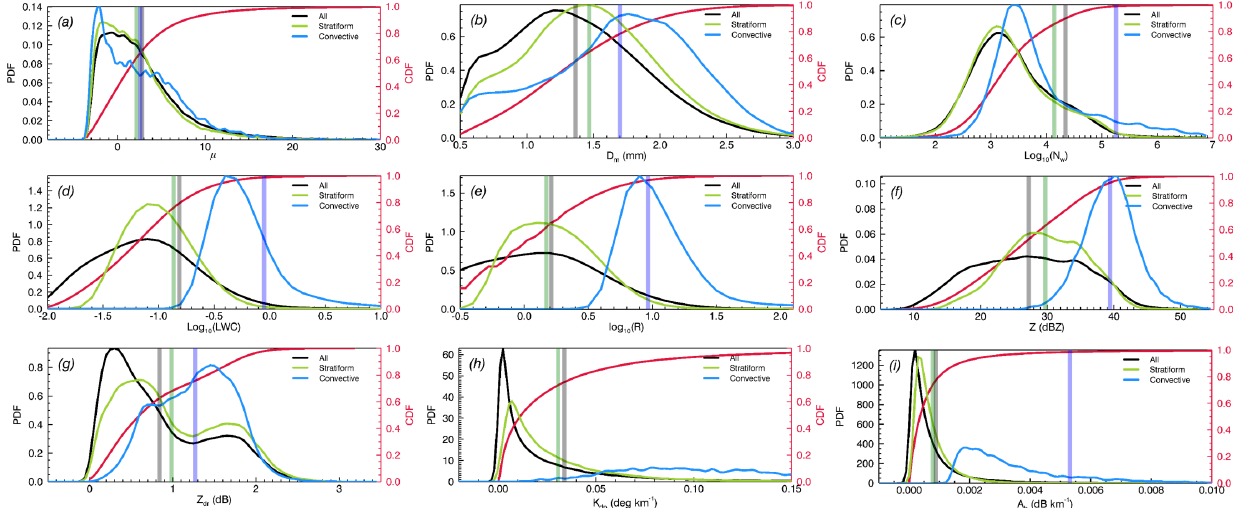
Figure 4. PDF and CDF for (a) µ, (b) D m , (c) log 10 (N w ) , (d) log 10 (R) , (e) log 10 ( LWC ) , (f) Z , (g) Z dr , (h) K dp , and (i) A h for the entire rainfall data set (solid black line), stratiform rainfall (solid green line), and convective rainfall (solid blue line). The solid red line represents the CDF for the entire rainfall data set. The solid vertical line represents the mean value of each type. Table 2. Designated date with respect to the source of rainfall. Rainfall category Period Typhoon 2001 2002 2003